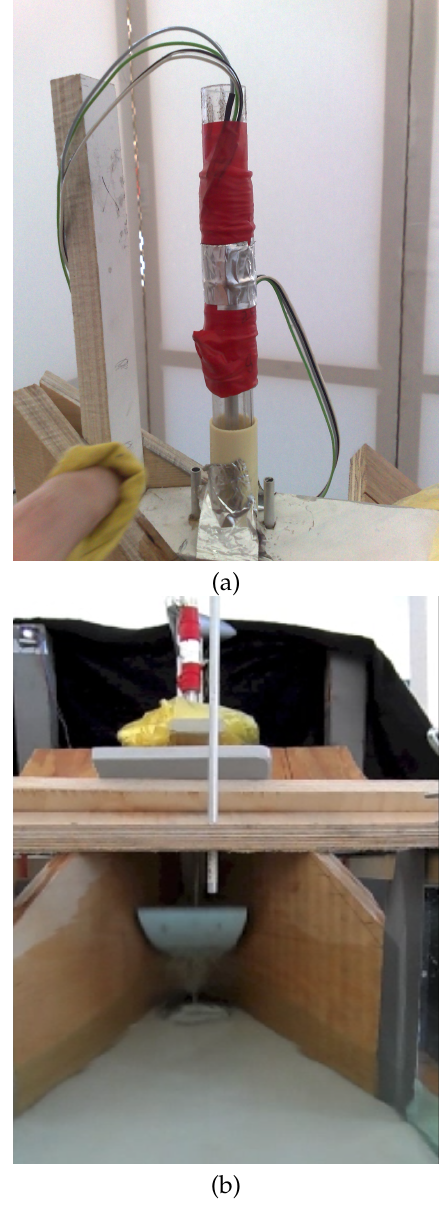
Fig. 1. A proof-of-principle of the scaled wave-energy device is shown: (a) a zoom-in of the electro-magnetic generator showing the hollow tube (covered in red tape) with its coils and the LED; the magnets on top of the buoy-mast move through the coils; and, (b) a view in the contraction with the buoy and a blinking LED light (top